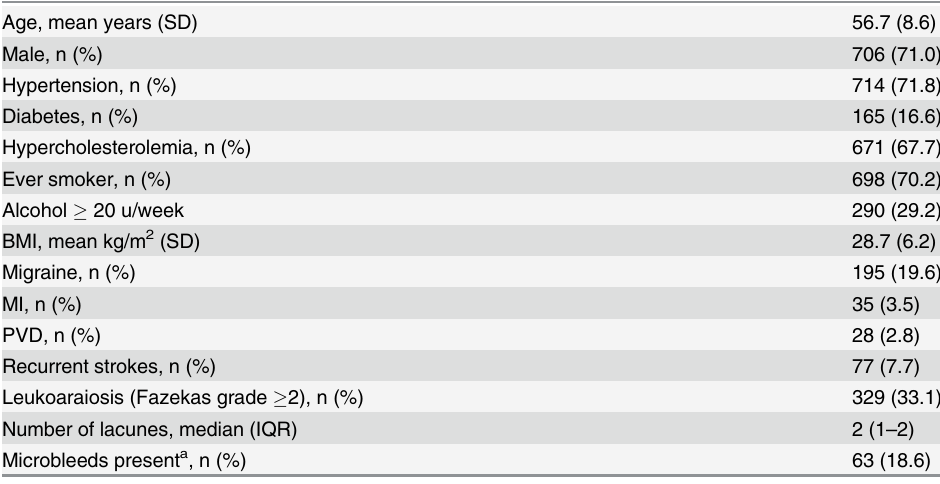
Table 1. Patient